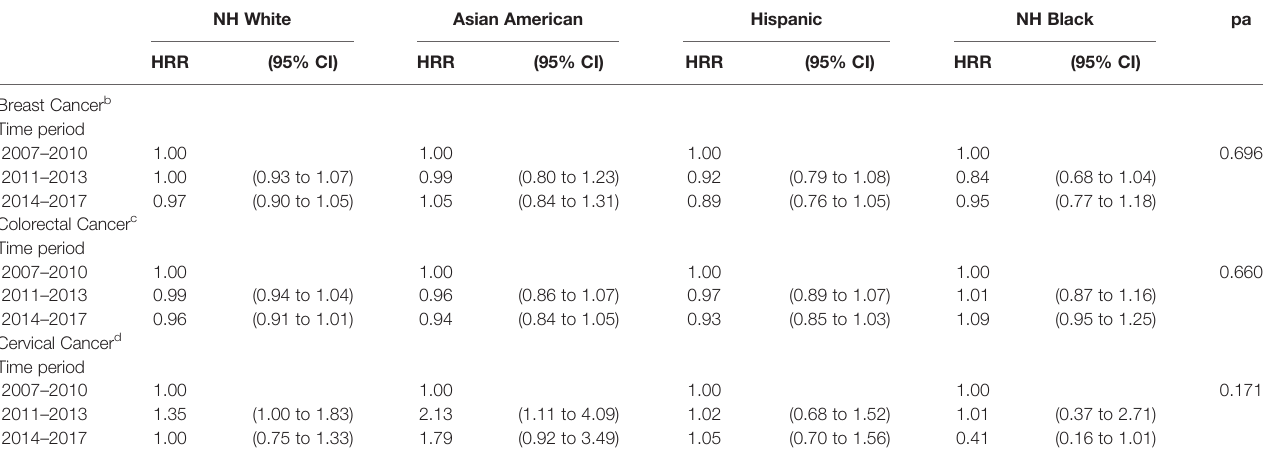
Bold text indicates statistical signi fi cance. a Global p-interaction in a fully adjusted overall model with underlying strati fi cation by race and ethnicity and including all possible cross-product interactions with race and ethnicity. b Breast cancer model adjusted for age, insurance status, marital status, tumor size, lymph node involvement, grade, histology, nSES, and NCI cancer center; with underlying strati fi cation by stage, HR/HER2 subtype, surgery, chemotherapy, and radiation; and clustering by block group. c Colorectalcancermodeladjustedforage,sex,insurancestatus,maritalstatus,tumorsize,lymphnodeinvolvement,histology,anatomicalsubsite,surgery,nSES,andNCIcancercenter; with underlying strati fi cation by stage, grade, chemotherapy, and radiation; and clustering by block group. d Cervical cancer model adjusted for age, insurance status, marital status, tumor size, lymph node involvement, grade, histology, surgery, nSES, and NCI cancer center; with underlying strati fi cation by stage, chemotherapy, and radiation; and clustering by block